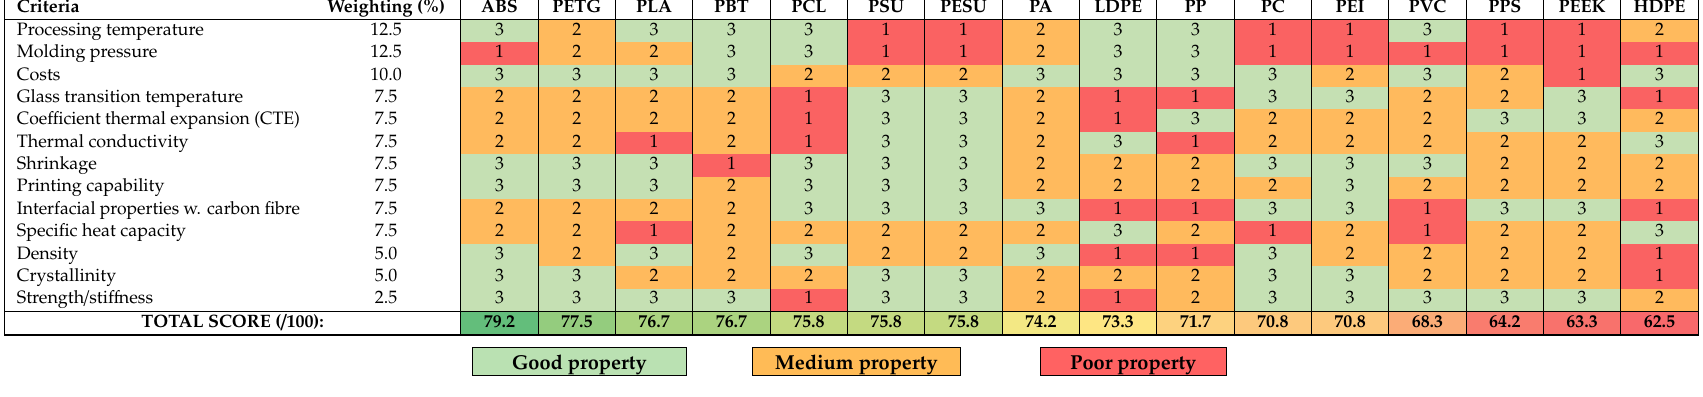
Table 2. Trade-off study of polymer matrices for ADFRCs suitable for 3D